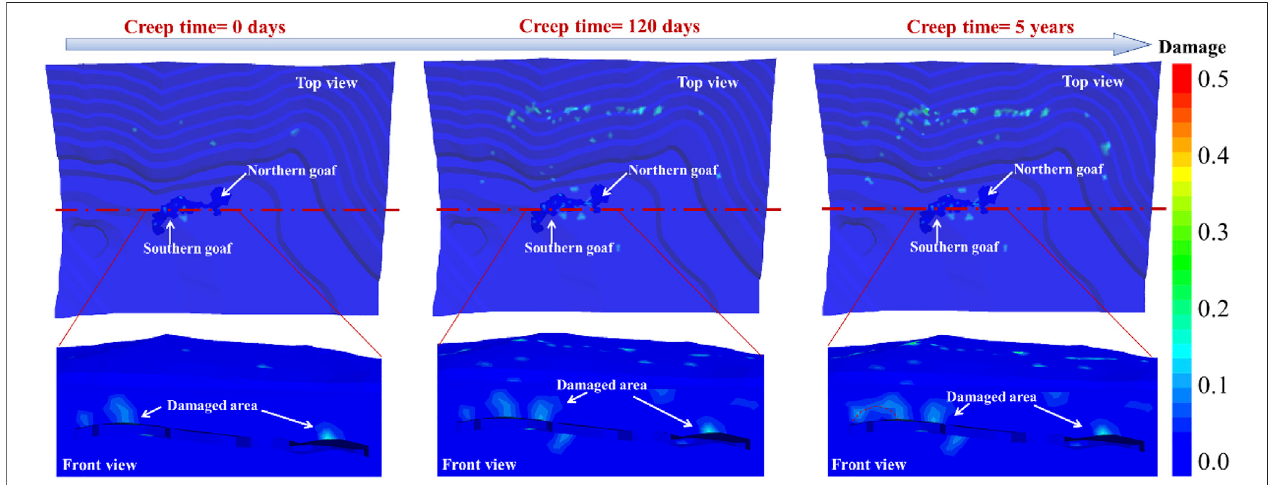
FIGURE 11 | Evolution of damaged area of goaf and surrounding rockmass during creep deformation process until 5 years.